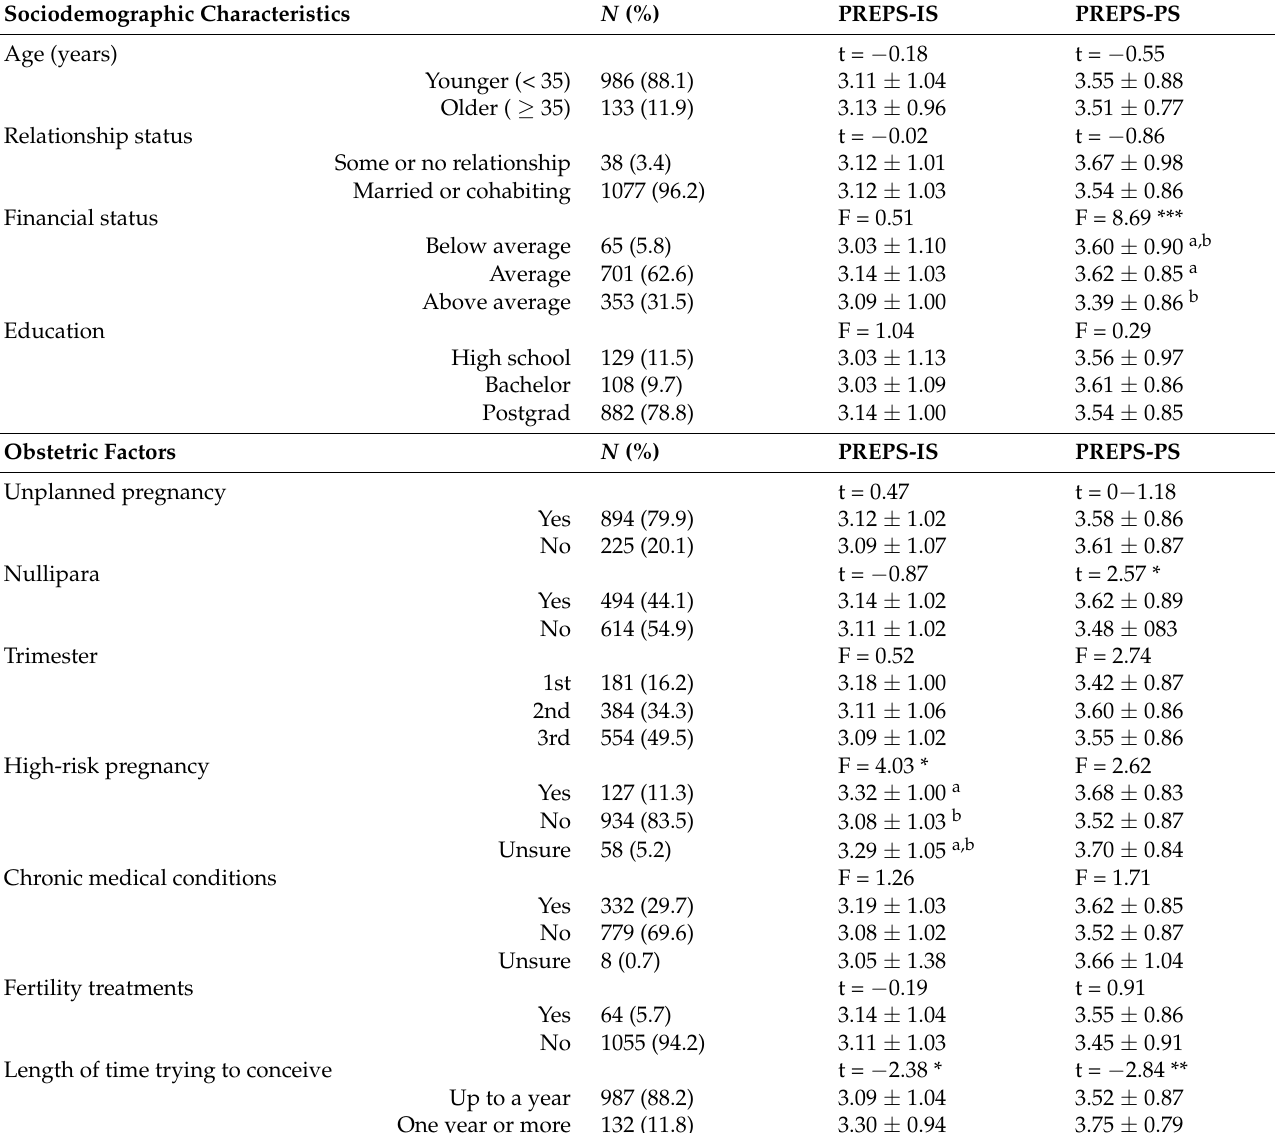
Table 1. Sample characteristics and mean differences in PREPS-IS and PREPS-PS scale score based on sociodemographic characteristics, obstetric factors, and other predictors ( N =